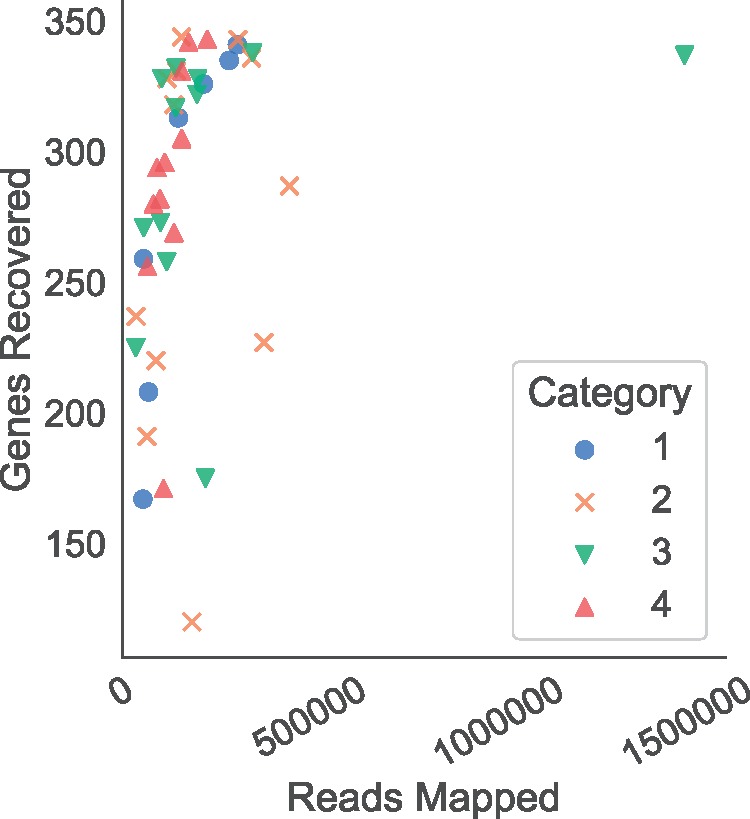
Relationship between reads mapping to the target genes and the number of loci recovered for 42 angiosperm species. There is a general linear increase in the number of genes recovered below 100,000 mapped reads, above which there are diminishing returns for additional sequencing.